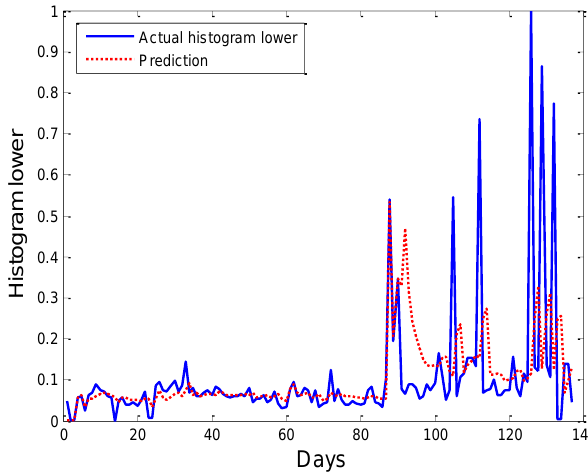
Figure 12. PANFIS prediction of histogram lower feature.